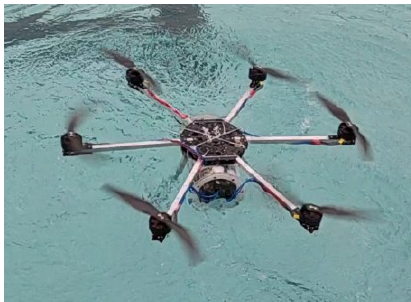
Figure 1. Water and air amphibious multi-rotor UAV physical picture.